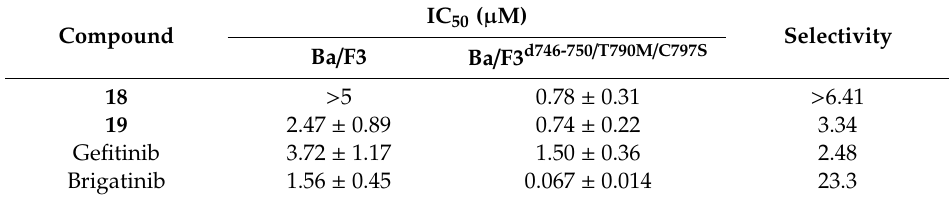
Table 4. Antiproliferative activities of 18 and 19 in wile-type and mutant Ba / F3 cell lines a